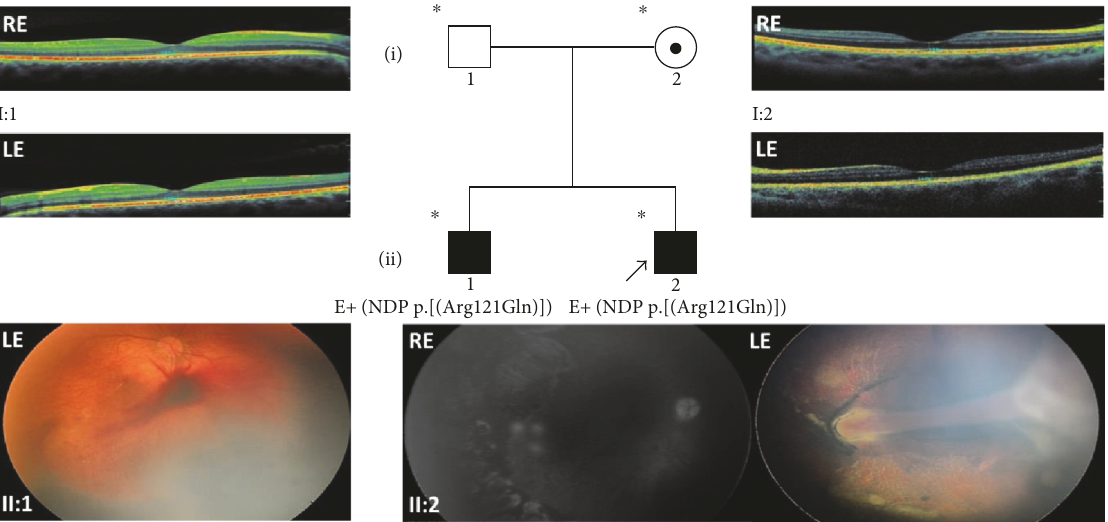
Figure 4: Pedigree and ocular features of family 4. Fluorescein angiograms by RetCam from the 7 y/o male proband (II:2) of family 4, showing FEVR stage 2B with slight optic nerve pallor, areas of chorioretinal atrophy due to previous laser treatment and a persisting small area of leakage in the peripheral retina of the RE. Color fundus photographs by RetCam of the LE with FEVR stage 3B clearly show the presence of a falciform fold arising from the optic nerve head, with partial traction on the surrounding retina. Stage 3A FEVR of the proband ’ s older brother (II:1) is shown in the color fundus photograph from his LE. Macular OCT images of proband ’ s father and mother are also shown in upper left and upper right quadrants of fi gure, respectively. The mother ’ s exam shows a slight reduction of macular thickness. ∗ Documented clinical evaluation; E+ and E − , positive and negative to genetic test, respectively; ● obligate carrier; RE, right eye; LE, left